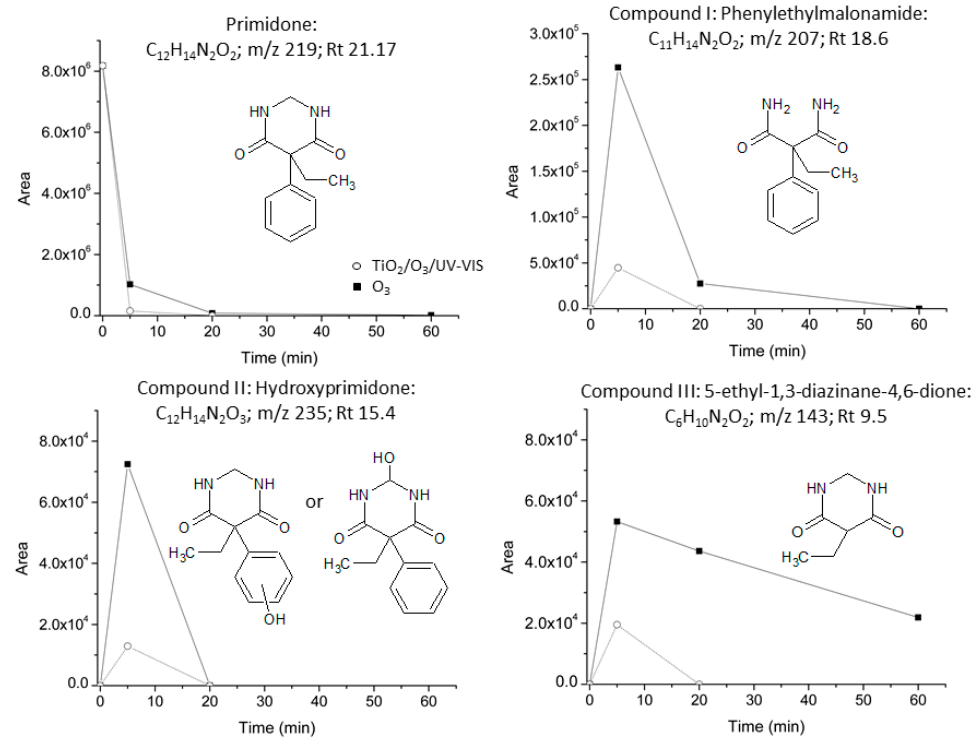
Figure 7. Evolution with time of the area of PRM and the intermediates detected by LC-QTOF-MS / MS during the application of O 3 and UV-VIS / TiO 2 / O 3 systems in ultrapure water. Experimental conditions as in Figure 4.